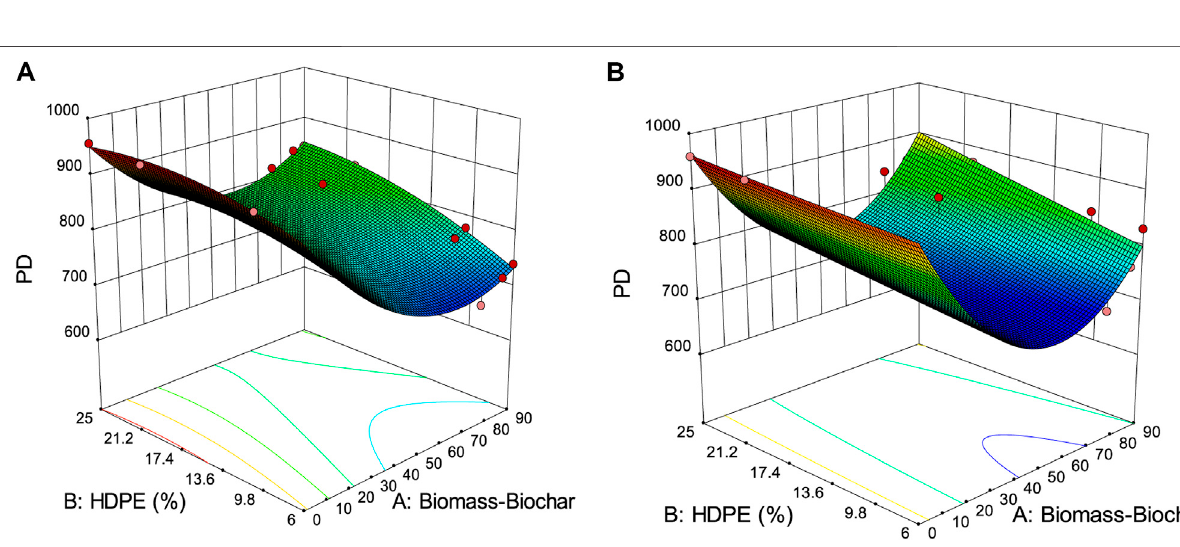
Frontiers in Energy Research |